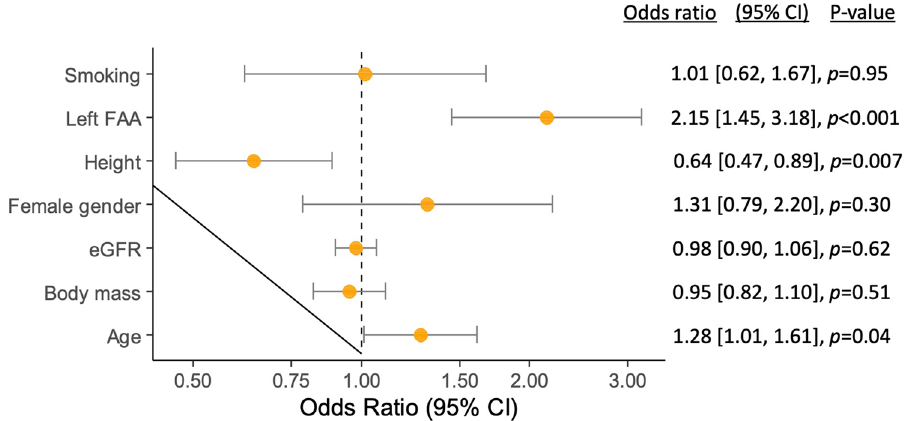
Figure 2. Multivariable logistic regression analysis of DVA in RUBR. Adjusted odds ratios with confidence intervals for difficult vascular anatomy (DVA) in RUBR were illustrated on a logarithmic scale for the following covariates: age (per 10-year increase), body mass (per 10-kg increase), estimated glomerular filtration rate (eGFR; per 10-ml/min/1.73 m 2 increase), female gender, height (per 10-cm increase), left forearm artery access (FAA) and smoking. RUBR radial-ulnar-brachial region.